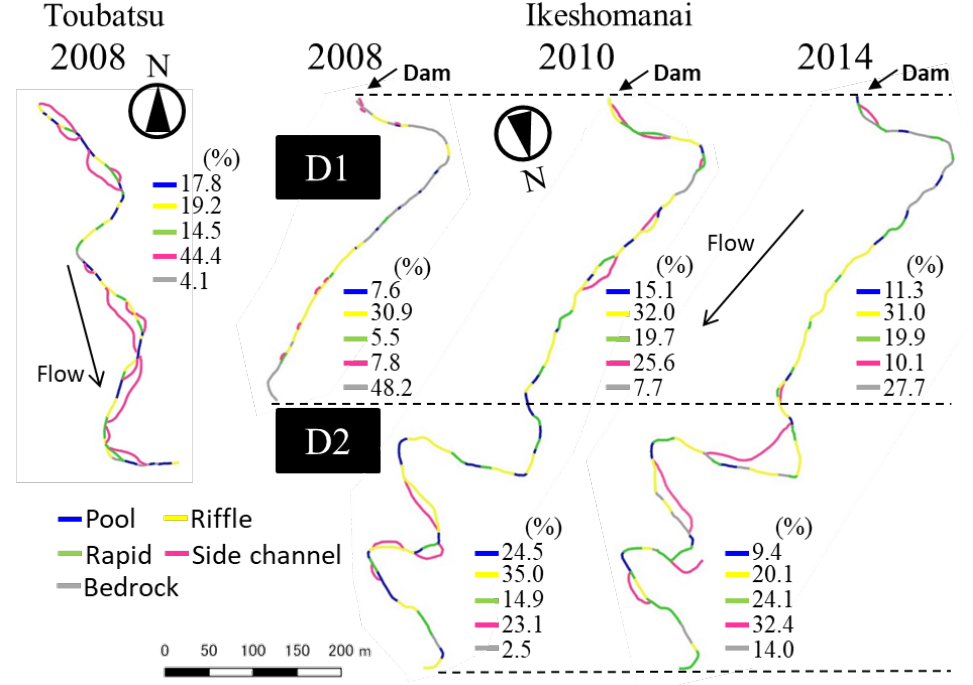
Figure 5. Spatiotemporal changes in the habitat distribution in the downstream section (D1 and D2) of the dam in the Ikeshomanai Stream before (2008) and after (2010 and 2014) dam removal (February 2009). The habitat distribution in the Toubatsu Stream, 2008 is also shown as reference. The numeric characters denote the percentage of habitat types in each study section in each year.